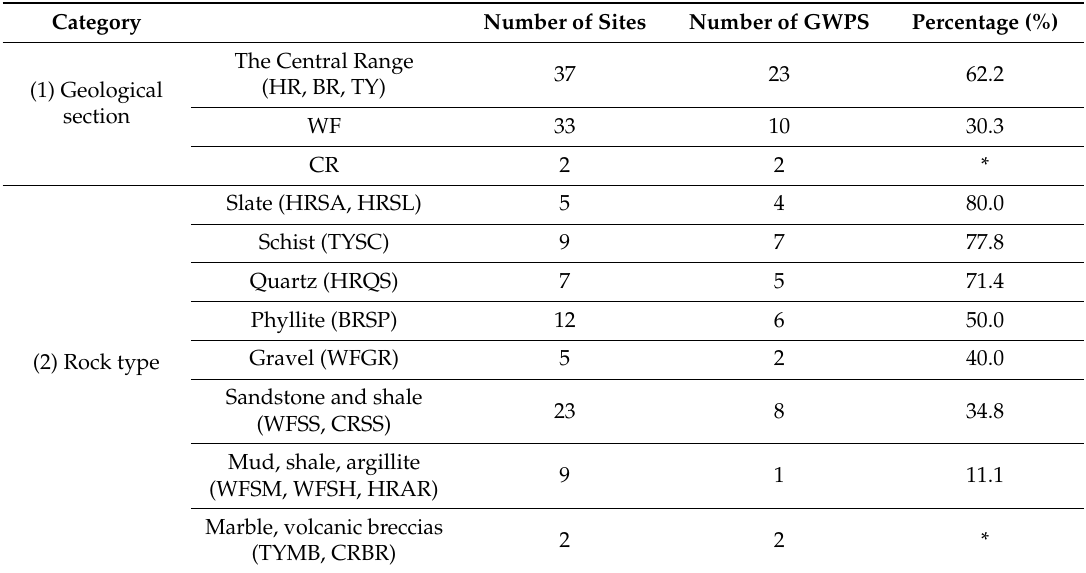
Table 6. Statistics of percentages of GWPS in the category of geological section and rock type.